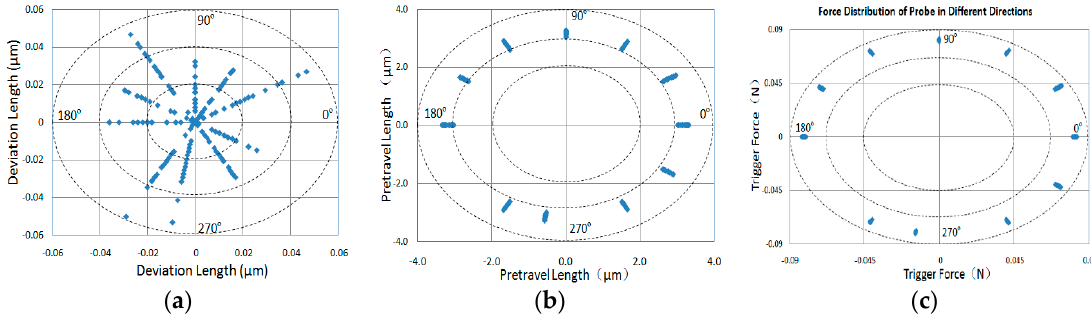
Figure 8. Error distribution of probe parameter calibration in different directions. ( a ) the repeatability error distribution of the trigger position of the probe; ( b ) the pre-travel distribution of the probe; ( c ) the measurement force distribution of the probe at the moment of trigger.